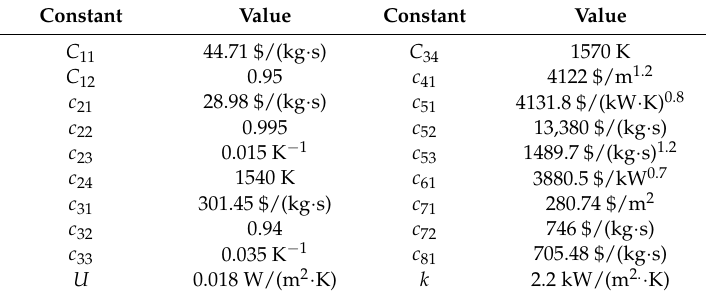
Table A2. Constants used in gas turbine cost